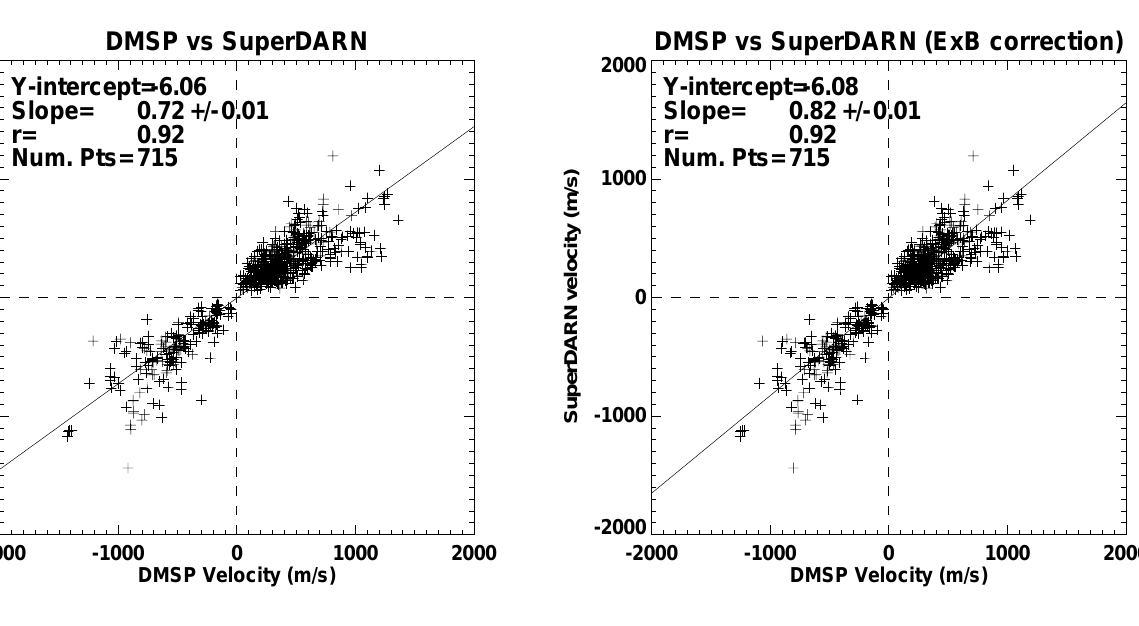
Fig. 13. Scatter plot of magnetically co-located plasma drift veloc- ity measurements by SuperDARN radars and DMSP satellites. The solid line represents a least-square linear fit.